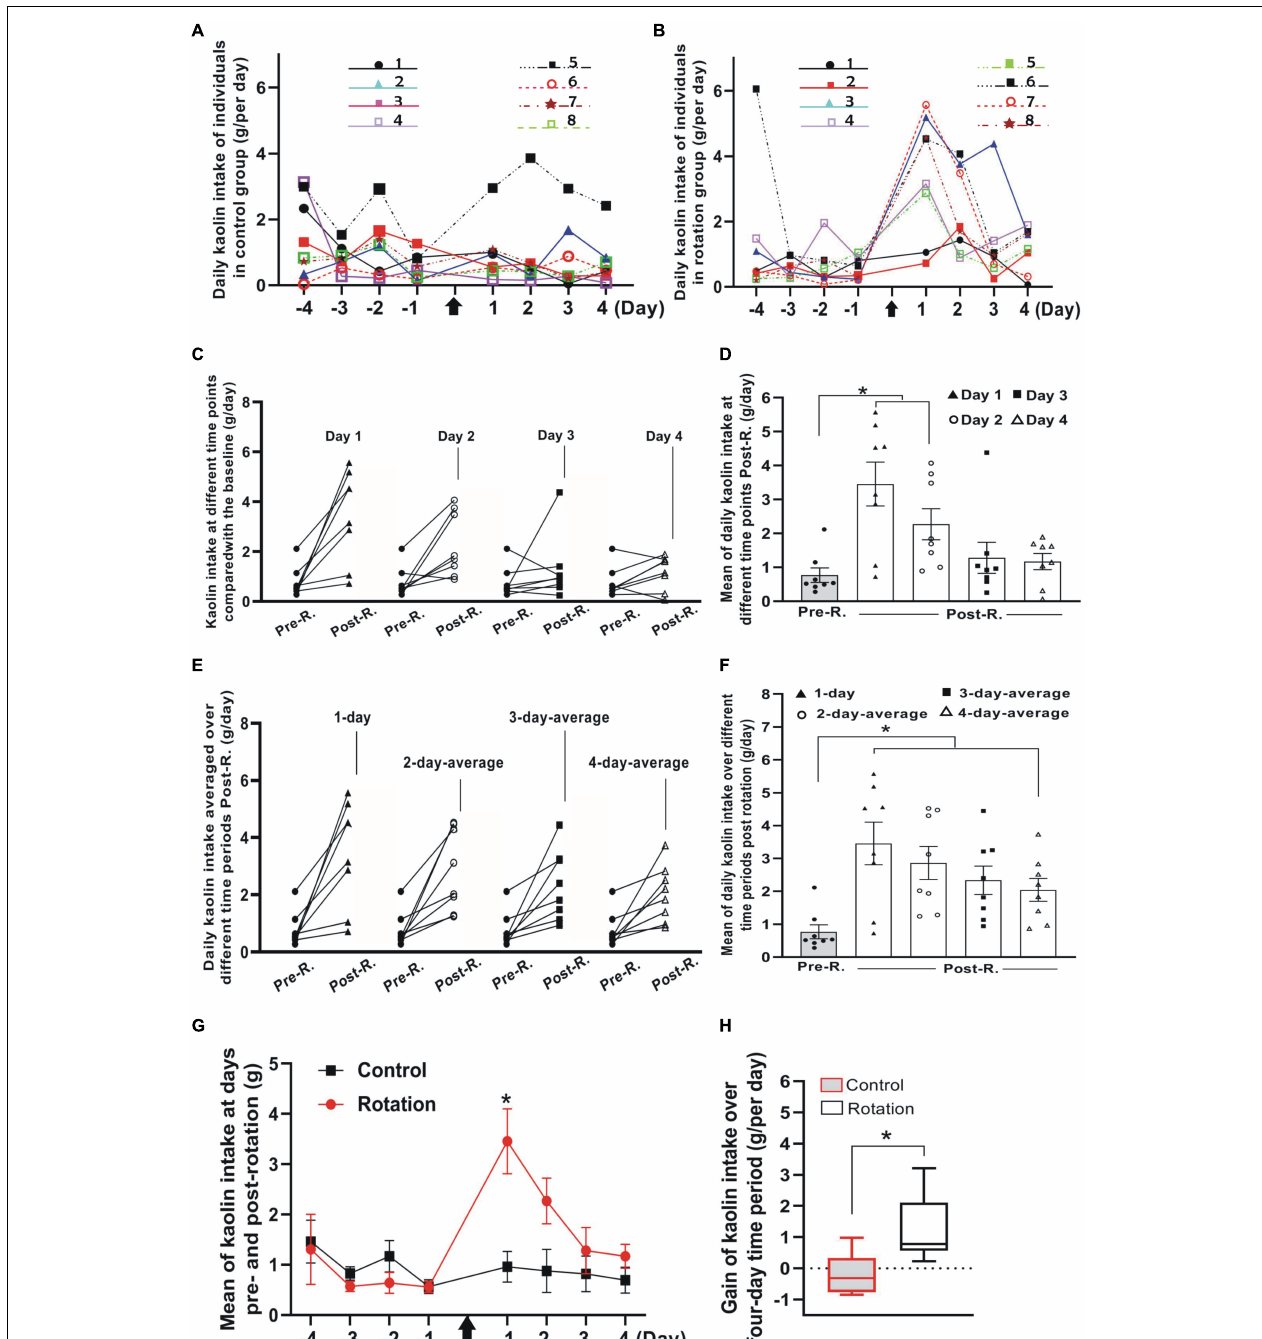
FIGURE 4 | The rotary stimulation-induced pica compared between control (pseudo-stimulation) and rotation groups ( n = 8 for each group). (A,B) Profiles of daily KI in Phase 1 and Phase 3 for all individuals in control (A) and rotation (B) groups. The numbered experimental animals were represented by different colored lines and symbols (inset). (C) The daily KI increased for the individuals after rotary stimulation. Note the differential slopes shown by the individuals in each of the four pair comparisons at different time points. Black filled circles indicate the individuals’ KI baseline. (D) Means of daily KI at day 1 to day 4. Black filled circles indicate the individuals’ KI baseline ( *p < 0.05, ANOVA with post-hoc test). (E) Average daily KI of each individual over 1-, 2-, 3-, or 4-day time periods after rotation was compared with its baseline (black filled circles), respectively. Note the interindividual difference in average daily KI represented by the individual slopes in each of the four-pair comparisons. (F) Mean of average daily KI over 1-, 2-, 3-, or 4-days following the rotation compared with mean of baseline (black filled circles) ( *p < 0.05, ANOVA with post-hoc test). (G) Profiles of daily KI over time before and after rotation for control and rotation groups ( *p < 0.05, ANOVA with post - hoc test ). (H) Comparison between control and rotation groups of gain in KI per day (g/day) over a four-day period following the rotation ( *p < 0.05, Mann–Whitney U -test). Black arrows indicate the time point when animals were rotated. See legend in Figure 2 for abbreviations.